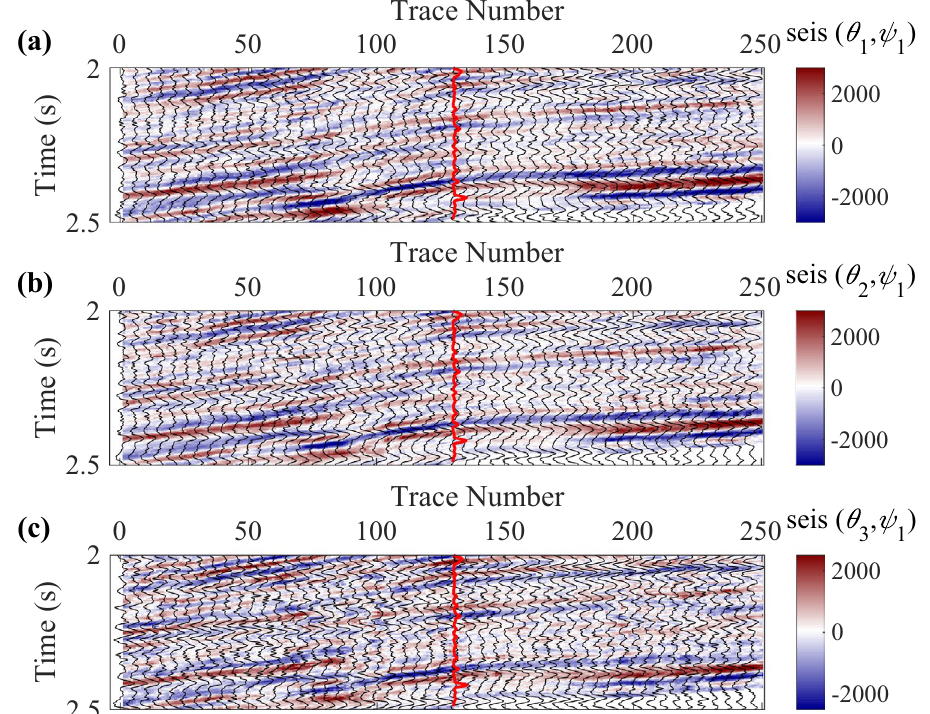
Figure 4. Angle-stacked seismic data in azimuth ϕ 1 = 40 ◦ , where (a) is the near angle of incidence (an average of 18° ranging from 14° to 22°), (b) is the middle angle of incidence (an average of 22° ranging from 18° to 26°), and (c) is the far angle of incidence (an average of 26° ranging from 22° to 30°), respectively.